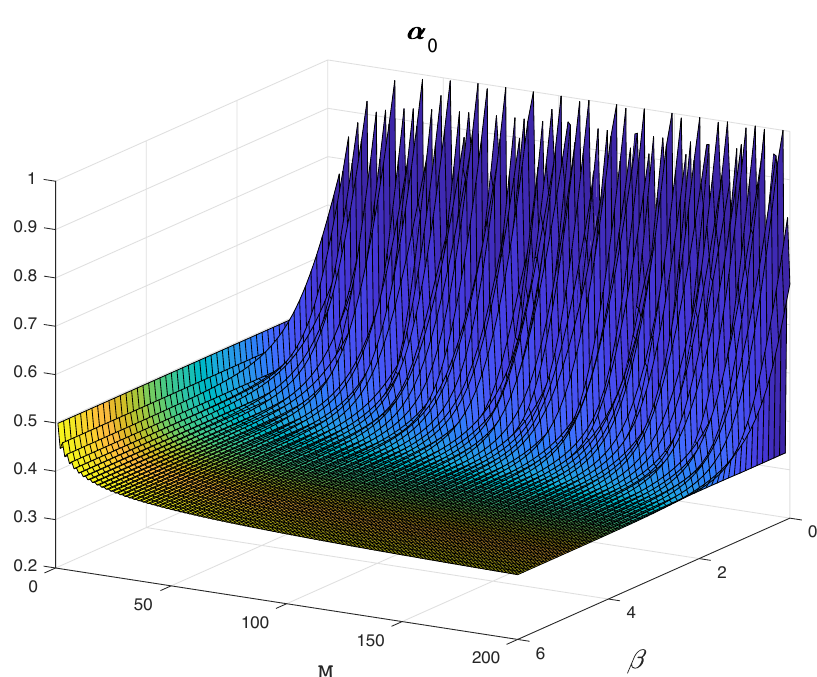
Figure 5 . Same as (cid:12)gure 3 when the summation in eq. (3.4) is restricted to odd